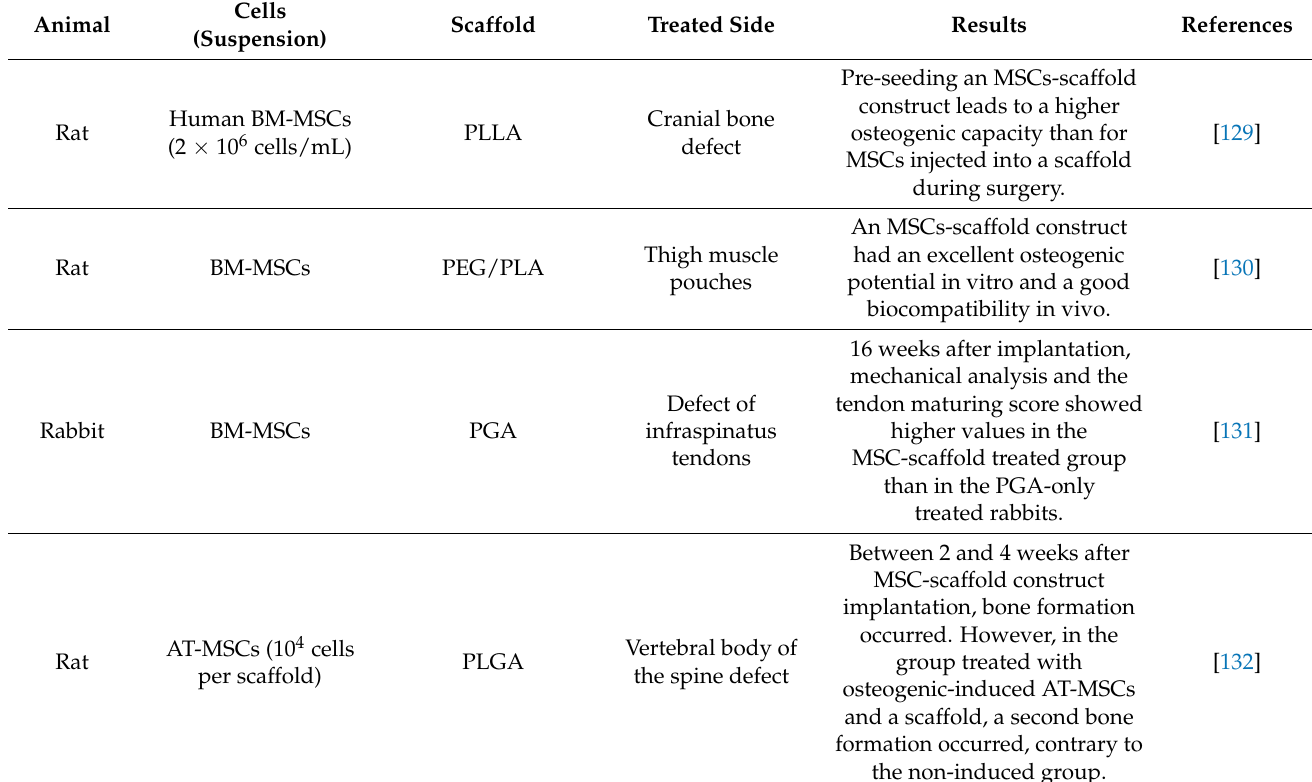
Table 1. In vivo studies using MSC-based therapies with scaffolds for bone regeneration. Cells Animal Scaffold Treated Side